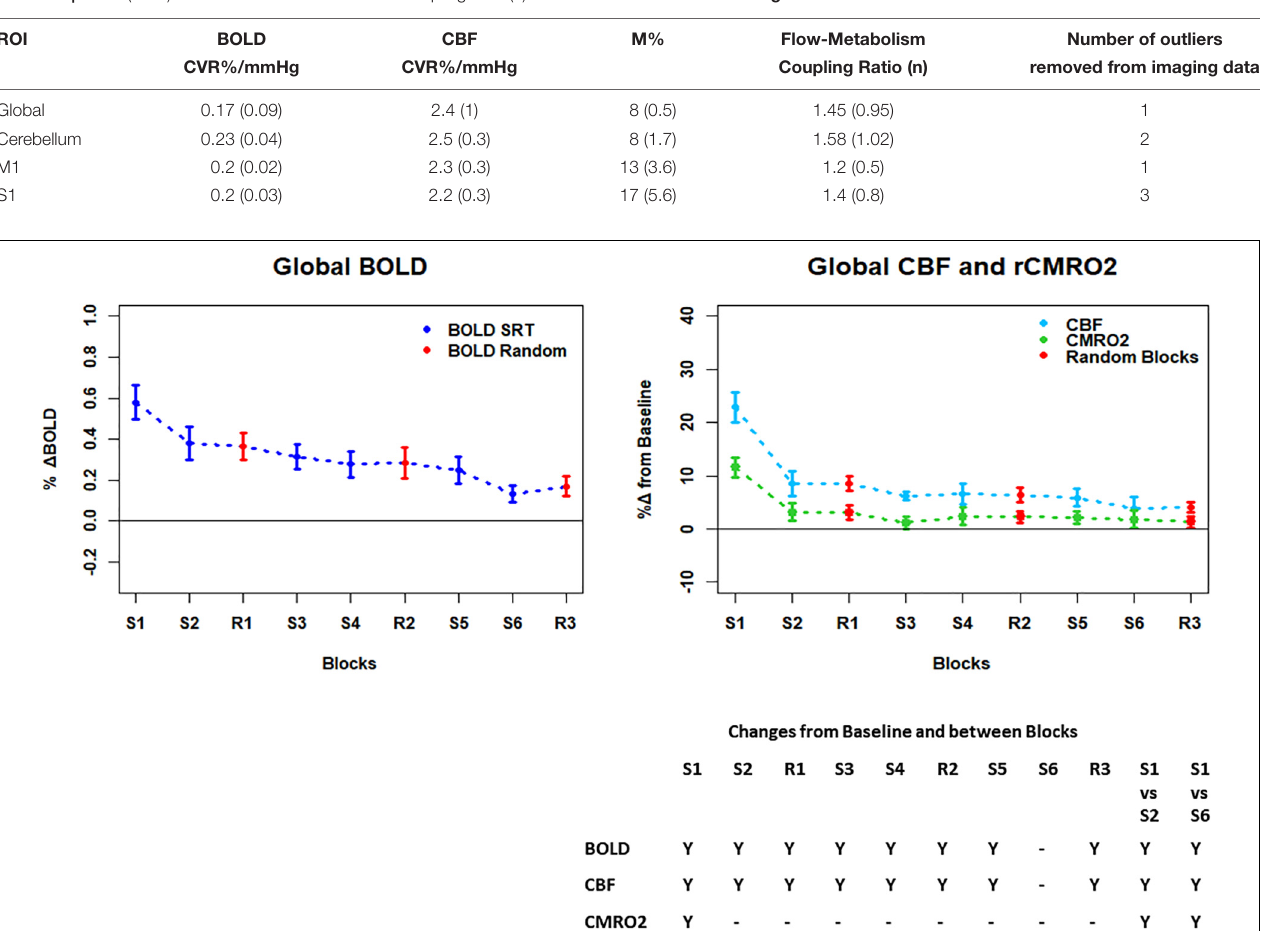
FIGURE 4 | Plots showing the mean ± SEM responses for each task block in the global mean reduction ROI shown in Figure 3F . S1 = SRT sequence block 1, R1 = pseudorandom block 1. Y = Yes to indicate statistically significant ( p < 0.05), signal changes from baseline and between first and second and first and last SRT blocks. BOLD and CBF showed significant increases from baseline across all blocks except the final sequence block S6. CMRO 2 was significantly higher than baseline in the first sequence block only. For BOLD, CBF, and CMRO 2 , there were significant reductions in the responses between the first and second and first and last sequence